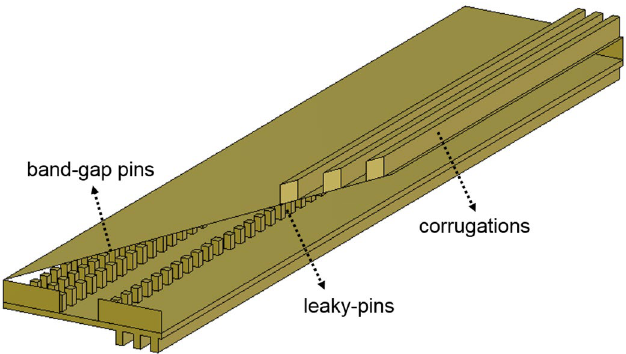
Figure 1. Model showing the leaky-wave antenna used as basic element for the proposed array. The model follows the example of the leaky-wave antenna proposed in 15